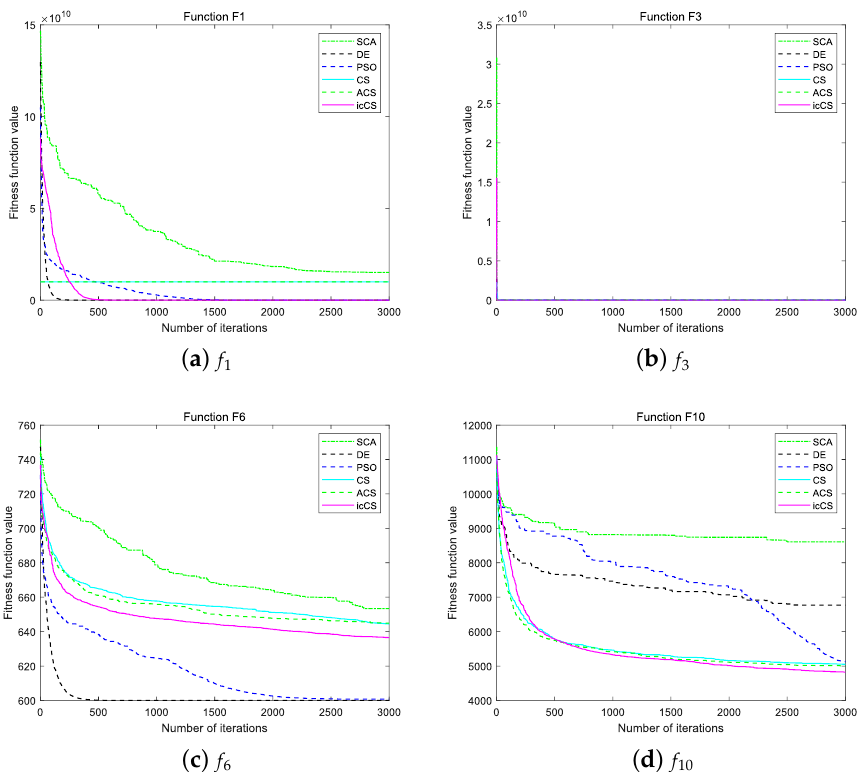
Figure 3. Convergence test results for functions f 1 , f 3 , f 6 ,and f 10 in 30 dimensions: ( a ) f 1 ; ( b ) f 3 ; ( c ) f 6 ; and ( d ) f 10